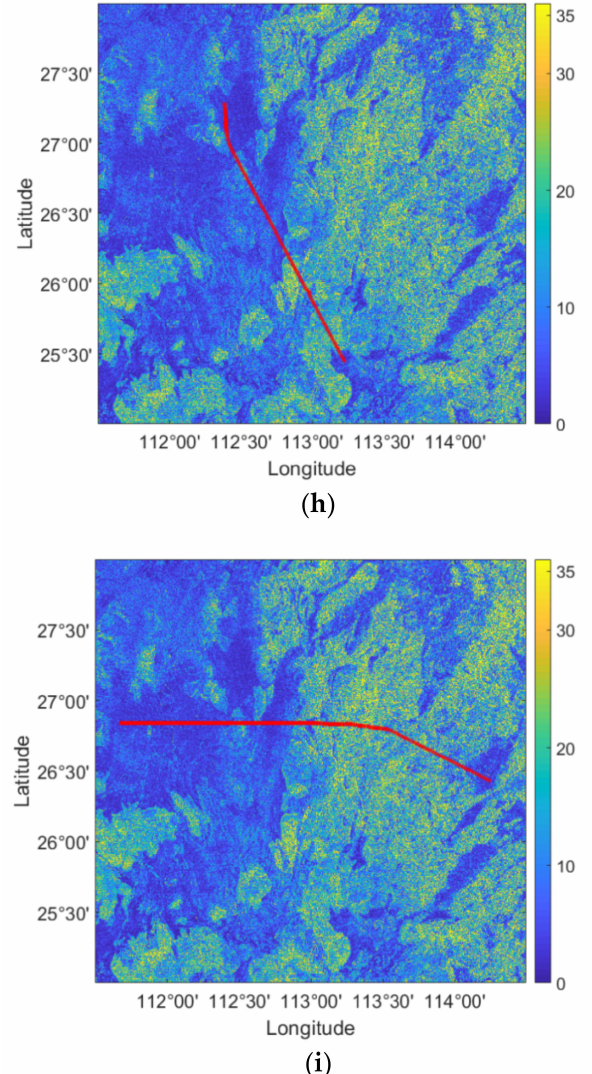
Figure 5. Short-, medium-, and long-distance planning path tasks for different vehicles. ( a ) Short distance of tracked lunar rovers with feasible slope threshold of 20 ◦ . ( b ) Medium distance of tracked lunar rovers with feasible slope threshold of 20 ◦ . ( c ) Long distance of tracked lunar rovers with feasible slope threshold of 20 ◦ . ( d ) Short distance of tracked vehicles with feasible slope threshold of 31 ◦ . ( e ) Medium distance of tracked vehicles with feasible slope threshold of 31 ◦ . ( f ) Long distance of tracked vehicles with feasible slope threshold of 31 ◦ . ( g ) Short distance of tracked vehicles with feasible slope threshold of 35 ◦ . ( h ) Medium distance of tracked vehicles with feasible slope threshold of 35 ◦ . ( i ) Long distance of tracked vehicles with feasible slope threshold of 35 ◦